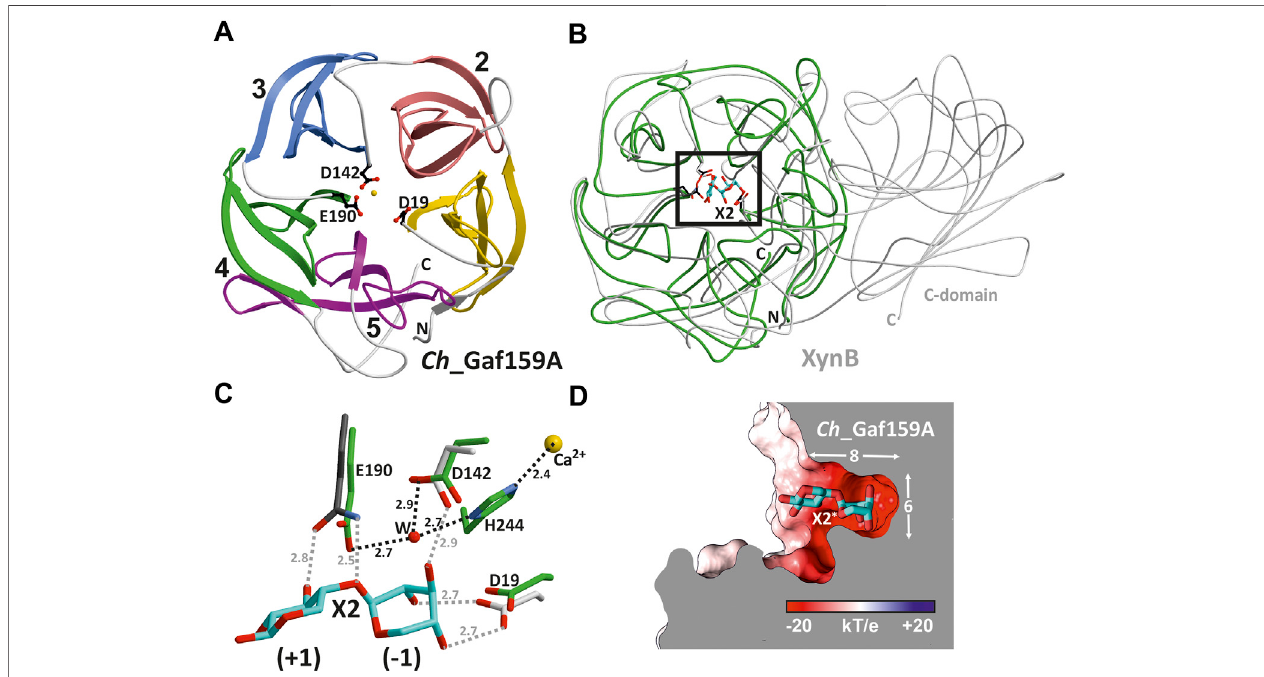
FIGURE 8 | Crystal structure of Ch _Gaf159A from Caldicellulosiruptor hydrothermalis . (A) Monomeric Ch _Gaf159A adopts a β -propeller fold (PDB ID 7ZEI) consisting of fi ve blades (ribbon drawing, linker regions in grey, N- and C-terminus marked in capitals) and houses a central metal ion (modelled as Ca 2+ , yellow sphere). The topology corresponds to glycoside hydrolase clan F. Asp19, Asp142 and Glu190 (shown in balls-and-sticks) are conserved residues in this enzyme class and form the catalytic center. (B) Superposition of Ch _Gaf159A (green) and mutant β -xylosidase (XynB, E186Q, PDB: 5ZQX, grey) in complex with xylobiose (X2, cyan). Ch _Gaf159A lacks the C-terminal β -sandwich domain that mediates homodimer formation in XynB (Hong et al., 2018). (C) Close up view of the active site (black rectangleinB).InXynB,hydroxygroupsofX2atposition( − 1)are fi xedbyanextensivehydrogenbondingnetwork.TheintroducedE186Qmutation(darkgrey)abolishes hydrolytic enzyme activity. Despite low sequence identity (15%) between Ch _Gaf159A and XynB, these residues match perfectly (labelled for Ch _Gaf159A). Distances are shown in Å, H-bonds for Ch _Gaf159A are drawn in black dots. (D) Surface representation of Ch _Gaf159A colored according to negative and positive electrostatic potentials.The modelled ligand(X2*) originates from thestructural overlay withXynB and aligns withthespeci fi city pocket (8 Å× 6 Å), indicating exohydrolase activity of Ch _Gaf159A.